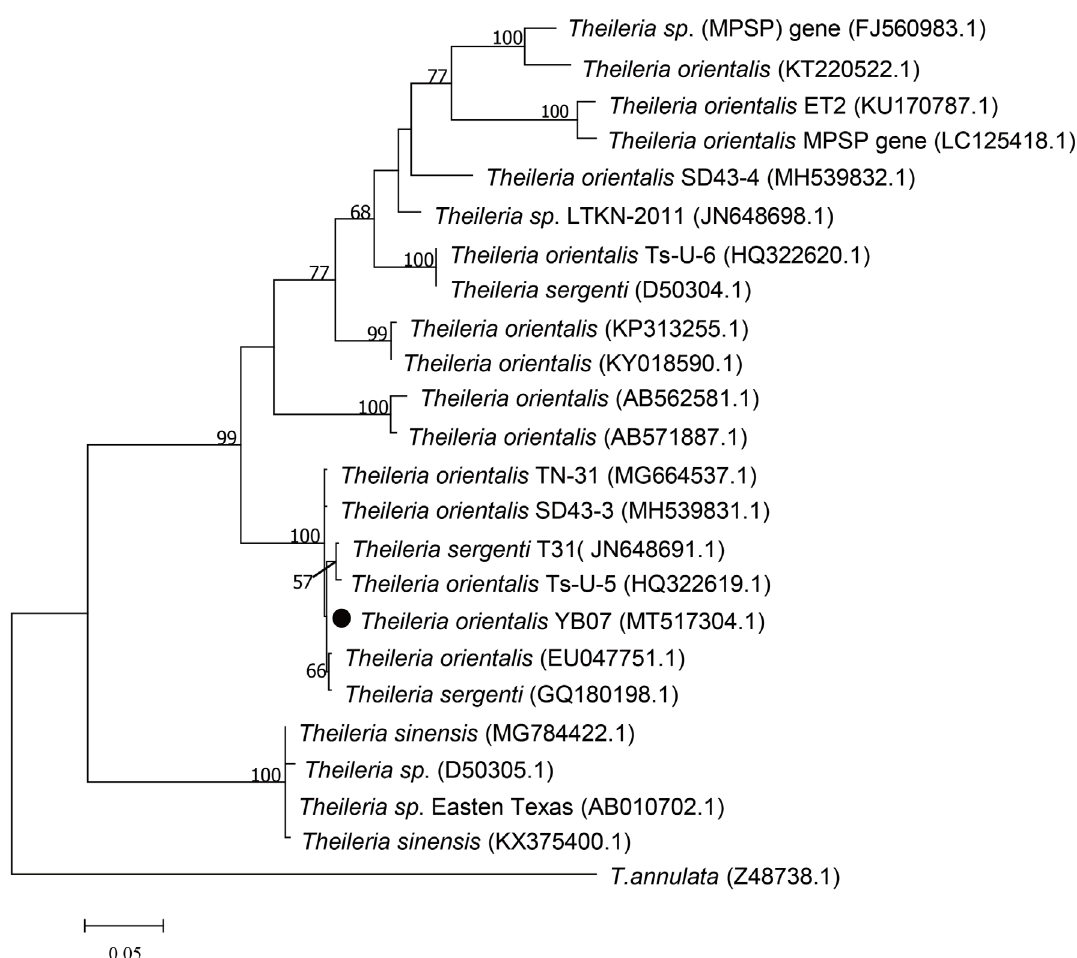
Figure 5. Phylogenetic tree based on the T . orientalis MPSP sequences obtained from Haemaphysalis longicornis . The ML trees were implemented by MEGA7 with a Kimura 2-parameter model . The numbers at the nodes represent percentage of occurrence of clades in 1 , 000 bootstrap replications of data . The gene sequence from this study is indicated by a round shape